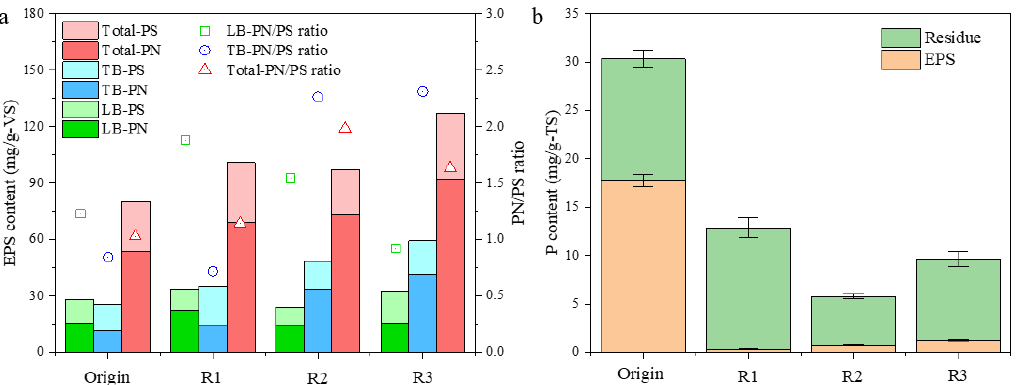
Figure 6. Changes of EPS ( a ) and phosphorus ( b ) content in biomass from R1, R2, and R3 after a 30- day aggregation process. LB-EPS: loosely bound EPS; TB-EPS: tightly bound EPS; residue: the residual part of microalgal biomass after EPS extraction.